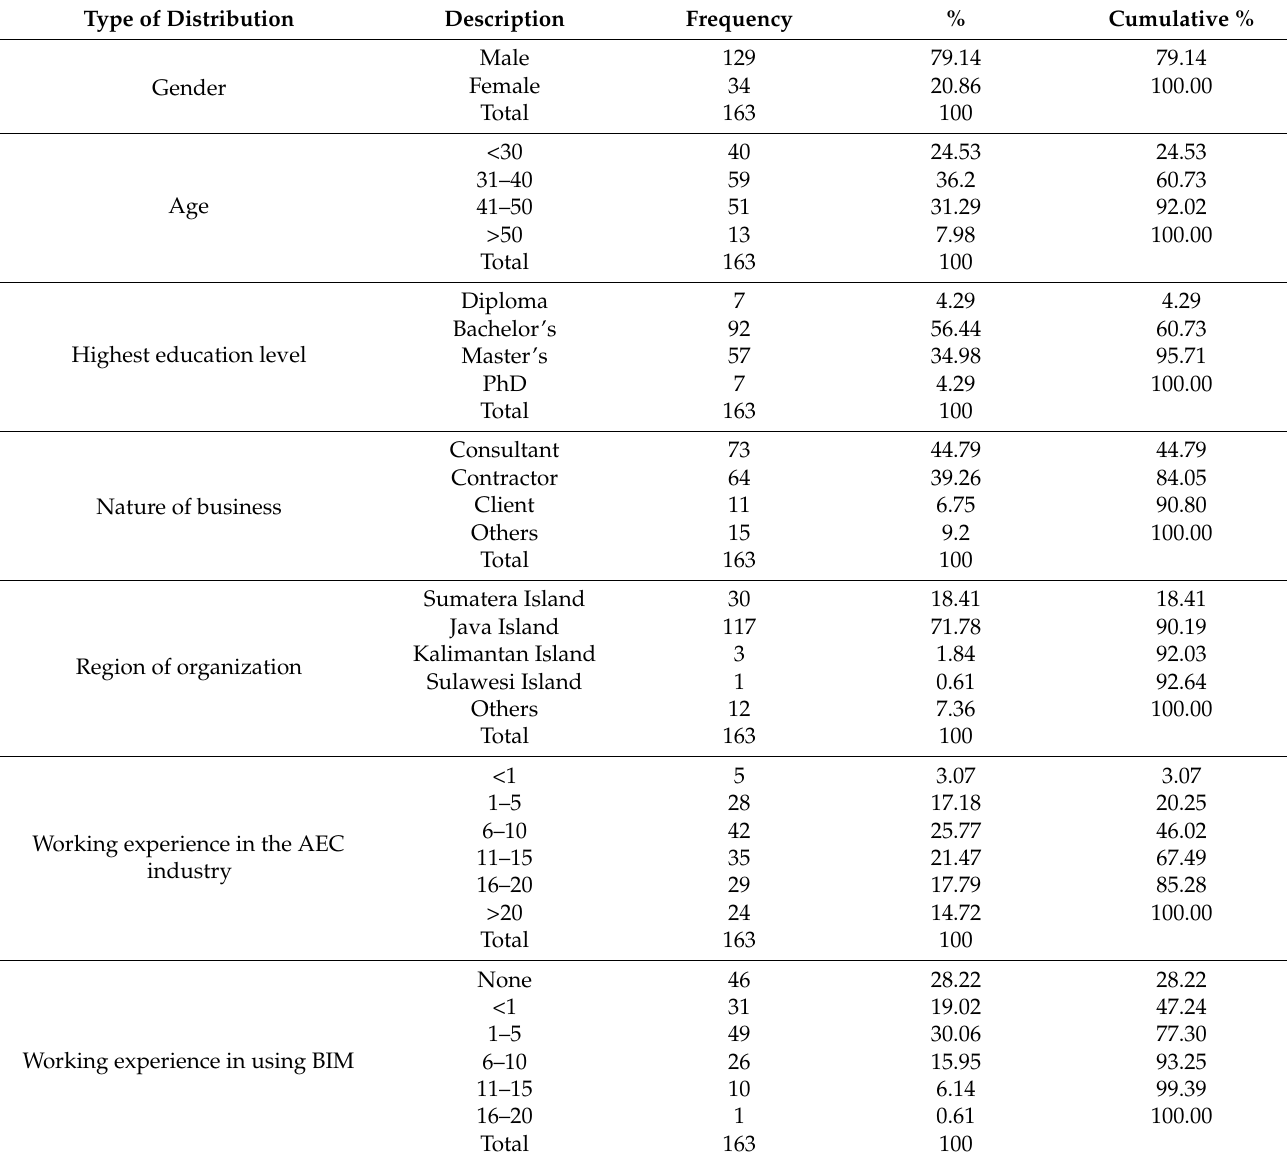
Table 2. Respondent